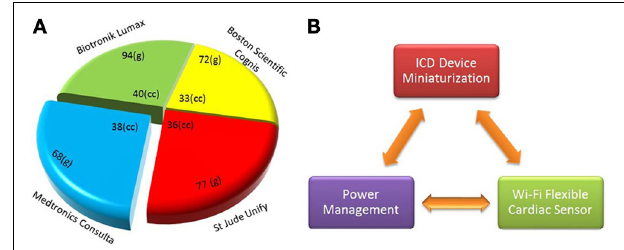
FIGURE 1 | Implantable cardioverter defibrillator (ICD) dimensional comparison and device integration scheme (A) size (cc) and weight (grams) of existing CRT-D devices by major market share (CRT-D, http://professional.sjm.com), (B) main components of proposed new generation ICDs are shown, such as device integration, power optimization, and Wi-Fi flexible